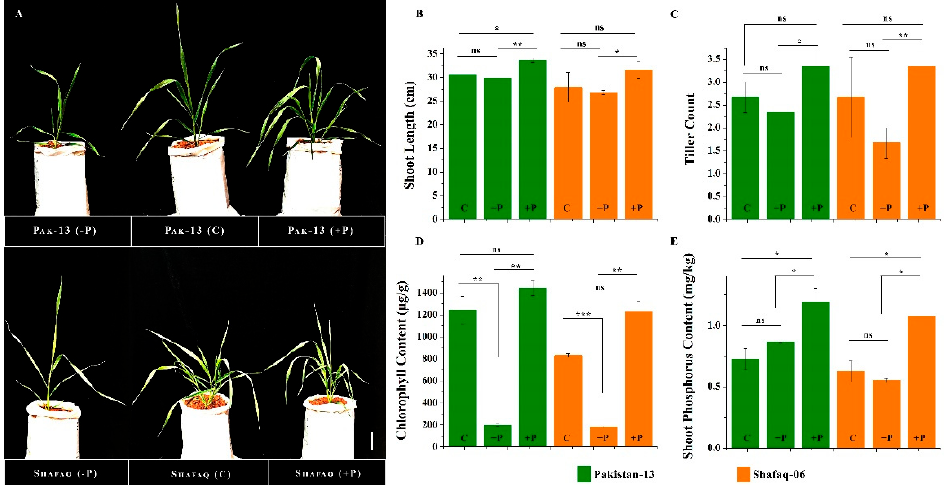
Figure 8. Plants’ response toward P-sufficient (+P), control (C) and P-starvation (-P) conditions. ( A ) Pakistan-13 and Shafaq-06 under low phosphorus ( − P), control ( C ) and high phosphorus (+P). Bar = 5 cm. ( B ) For both (Pakistan-13 and Shafaq-06) genotypes shoot length (cm), ( C ) tillers count, ( D ) chlorophyll contents, and ( E ) shoot phosphorus contents. Presented data are the mean of five biological replicates. Asterisks on bars indicate significant difference determined by t-test with p < 0.05 (*), p < 0.01 (**), and p < 0.001 (***).